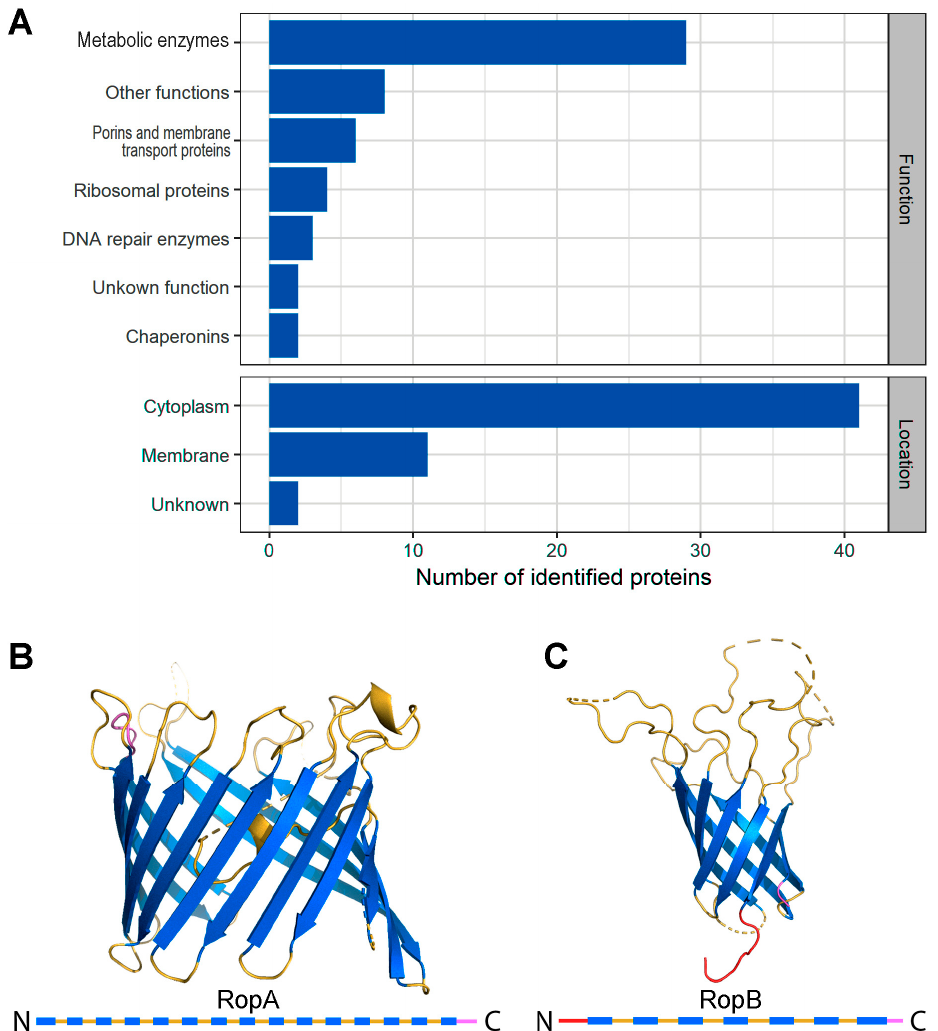
Figure 1. Detergent-resistant fractions of Rhizobium leguminosarum and proteins comprising them. ( A ) Functions and locations of proteins comprising detergent-resistant fractions based on UniProt data (https://www.uniprot.org/). ( B , C ) Structures of RopA and RopB proteins, respectively, predicted with I-TASSER server [56]. Secondary structures of RopA and RopB are presented below with bars. Blue bars denote beta-sheets, yellow ones denote loops, and red and purple bars denote the N -terminus and C -terminus, respectively.